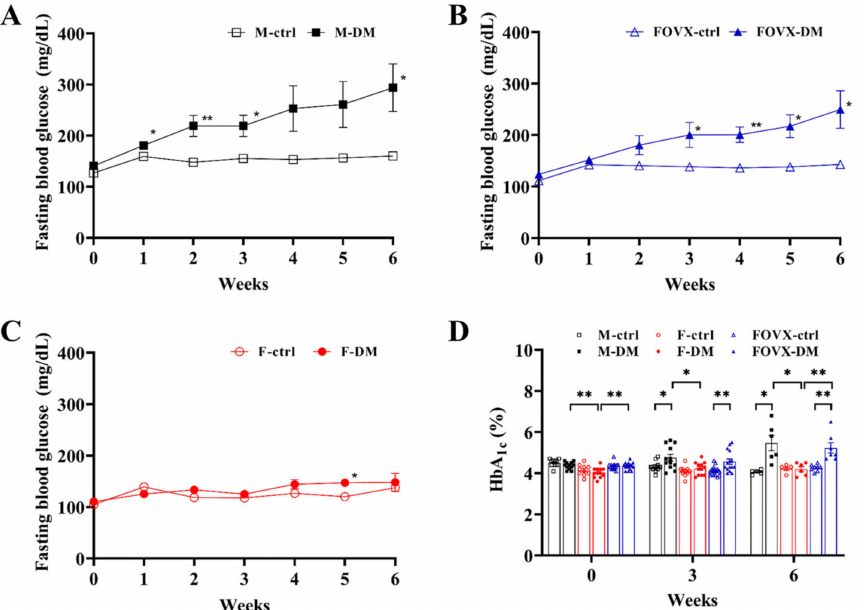
Figure 1. Changes in fasting blood glucose (FBG) and hemoglobin A 1c (HbA 1c ) levels in STZ-treated diabetic mice over 6 weeks. FBG levels of male ( A ), ovariectomized female ( B ), and female ( C ) groups. ( D ) HbA 1c levels at 3 and 6 weeks after STZ treatment. FBG and HbA 1c levels of FOVX-DM mice were significantly increased compared with those of F-DM mice. Data were analyzed using an independent two-sample t -test. * p < 0.05, ** p < 0.01 compared with the respective control